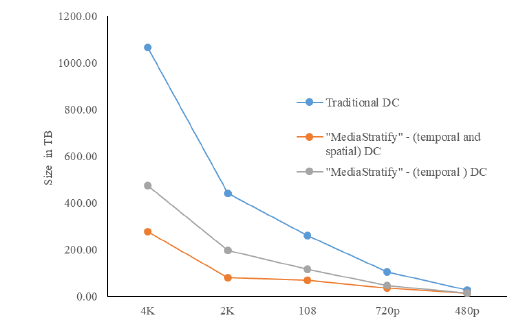
Figure 9. Storage savings due to "MediaStratify" for contents in [6]